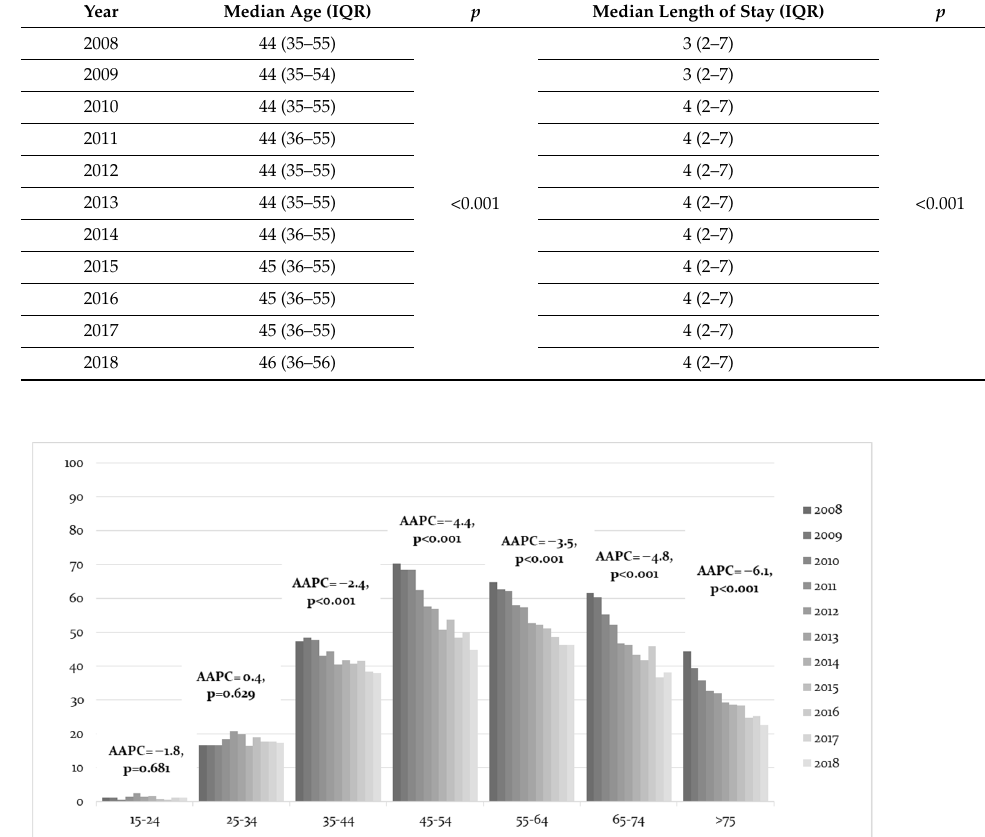
7 of 14 Table 3. Female patients’ median age and median regarding the length of hospital stay for cervical